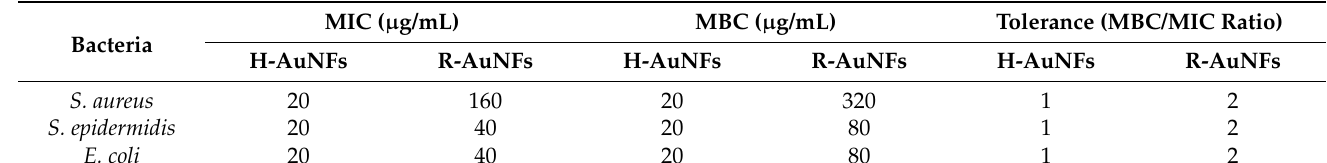
Table 1. The MIC and MBC values of AuNFs against tested bacterial strains.